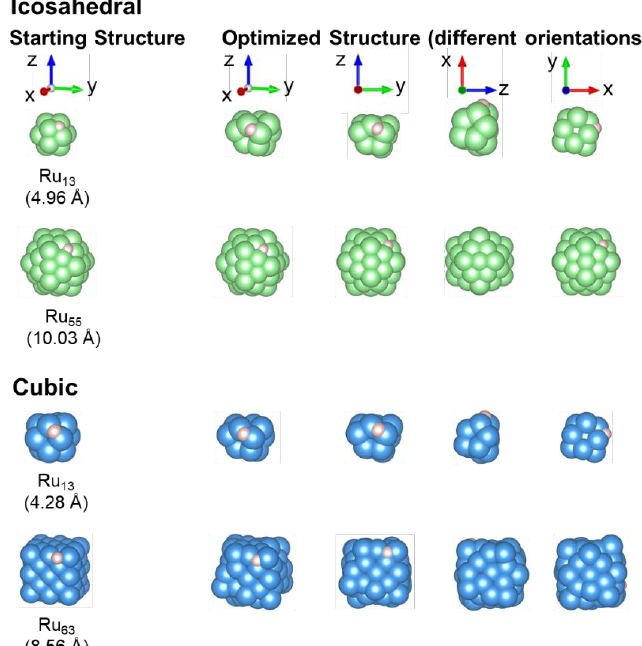
Figure 3. Hydrogen adsorption onto the icosahedral and cubic Ru fcc nano-dots for two different sizes, showing initial and optimised structures. The calculations for all the nano-dots included both the spin-polarised and non-spin- polarised settings, and for the icosahedral and cubic Ru 13 nano-dots they also included calculations with the initial magnetic moment set to one ( μ i = +1) to account for the addi- tion of H, in addition to the spin- polarised calculations with the ∆e ↑↓ configurations set both to zero and to one. Table 4 lists the resulting data from the DFT-D3 and DFT-D3(BJ) methods. Table 4. System energy ( E 0 ), adsorption energy (E ads ) and total resulting magnetic moment ( μ B,tot ) for the fcc Ru icosahedral and cubic nano-dots of two sizes, with H-adsorption onto the fcc hollow site to include the spin-polarised (SP) and non-spin-polarised (NSP) contributions, different initial mag- netic moments ( μ i ) and init ial electron orientation distribution (∆e ↑↓ ) configurations, obtained with DFT-D3 and DFT-D3(BJ). −